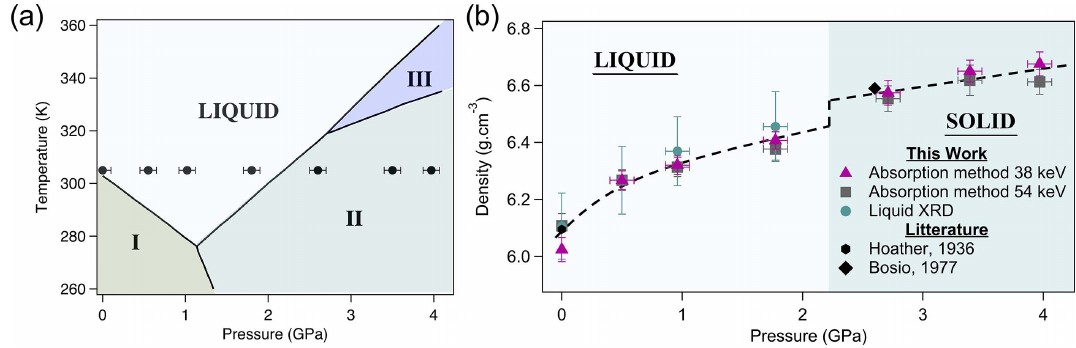
Figure 4 ( a ) Phase diagram of gallium (Bosio, 1978). The experimental pathway for density measurements and liquid X-ray diffraction is denoted by the black